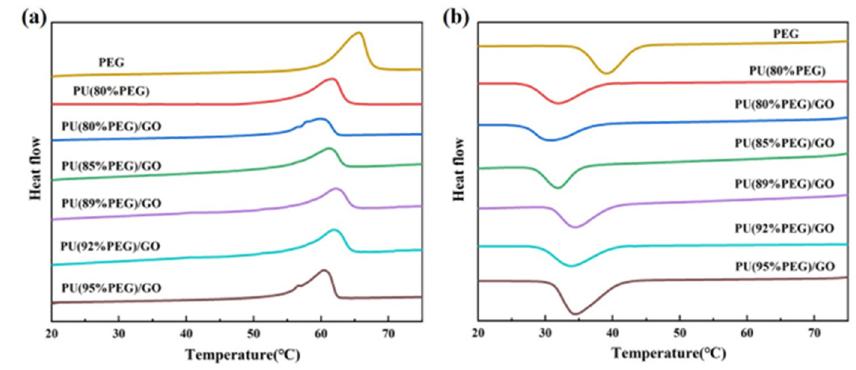
Figure 4. DSC curves of PU/GO during heating ( a ) and cooling ( b ).